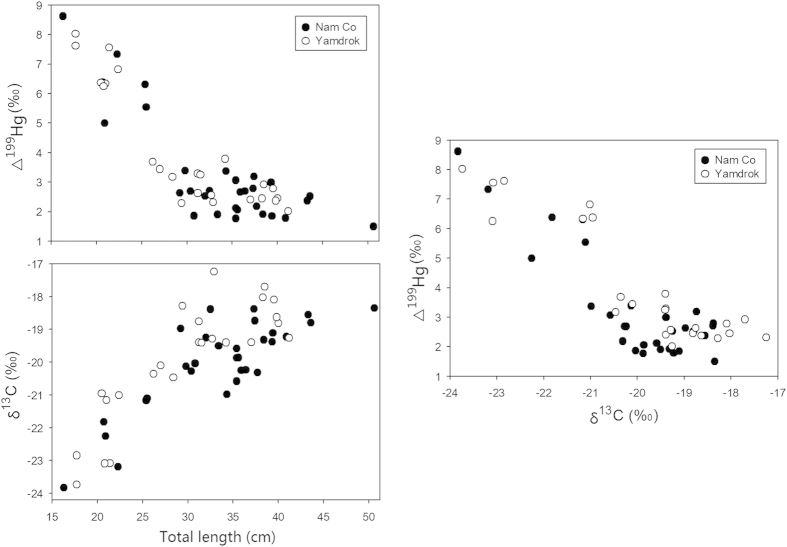
The relationship among Δ199Hg, δ13C, and total body length in fish adult.Filled circle stands for fish from Nam Co Lake, and open circle stands for fish from Yamdrok Lake.